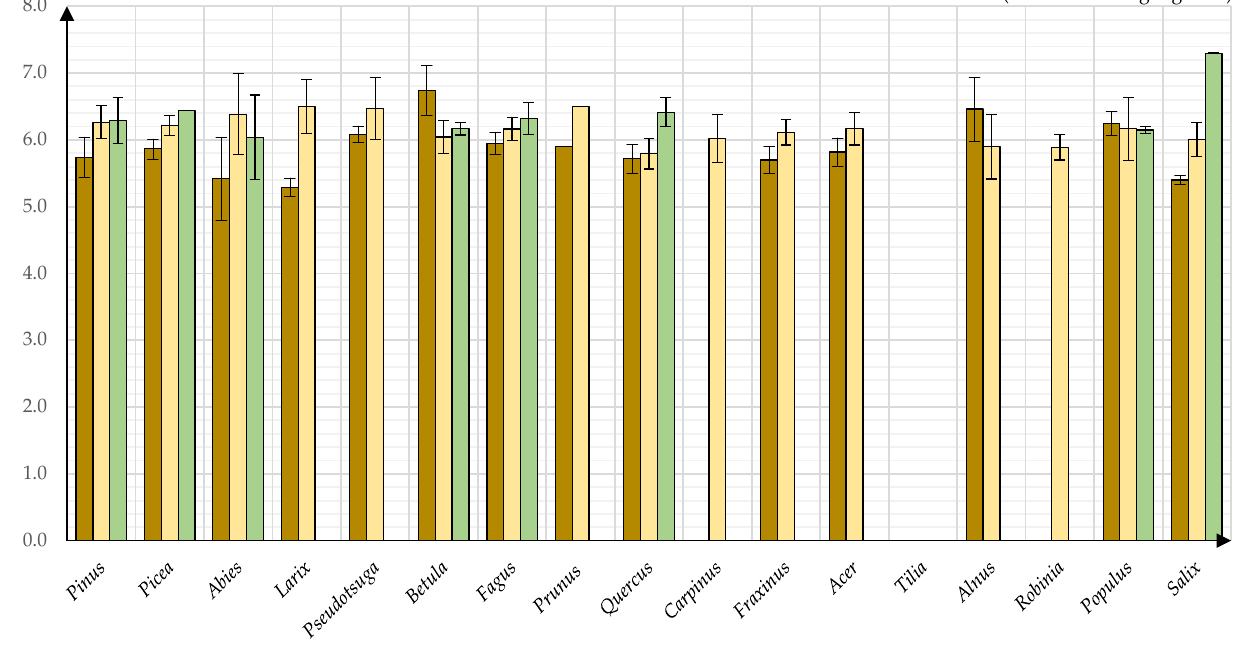
Figure 10. Average value and average deviation of the hydrogen content of organs of particular systematic genera trees.